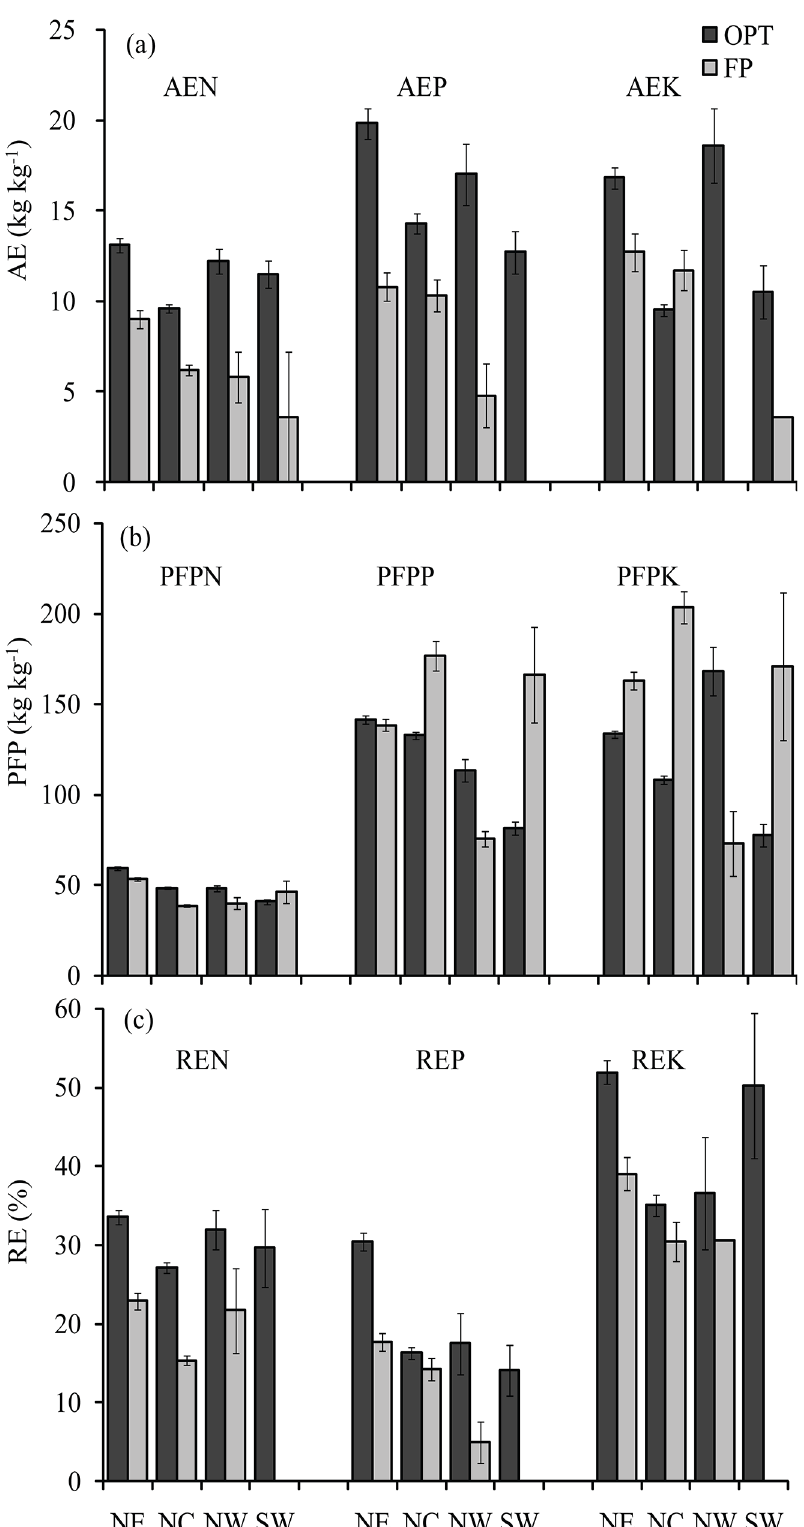
Fig 4. Descriptive statistics for agronomic efficiency (AE), partial factor productivity (PFP) and recovery efficiency (RE) in the optimal treatment (OPT) and farmers ’ practices (FP) for maize in different production regions of China. Error bars represent standard